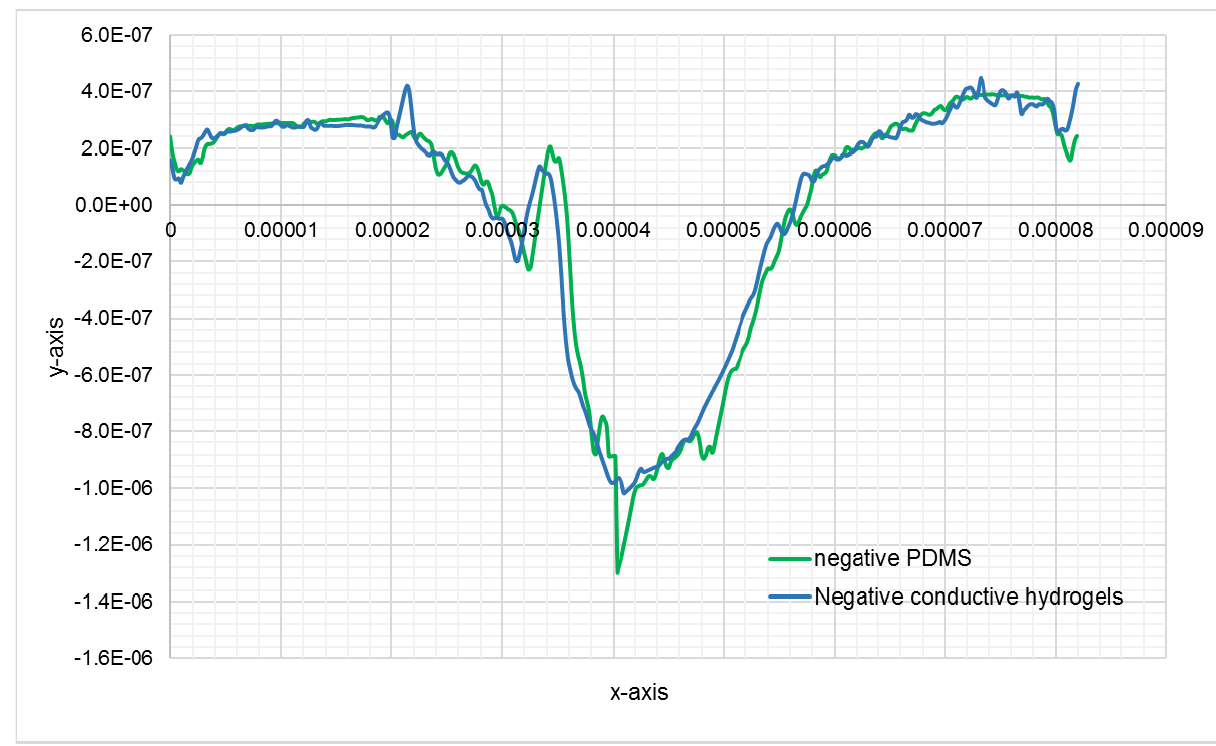
Figure 8. Comparison of the topographic profiles of the cross section of the cell shown in Figure 8, on negative PDMS bioimprint and negative conductive hydrogel bioimprint, y scale units is in meter.